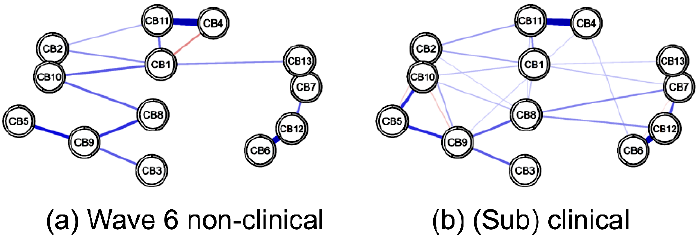
Figure 5. Comparison of the ( a ) nonclinical and ( b ) (sub)clinical CBCL 13-node networks. The shaded rings around each node indicate predictability (%).